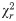
Results from reweighting the simulation with underestimated protein-water interaction strength (λ = 1.04).(A) Fit to SAXS data with adjusted force field before (black) and after reweighting at θ = 500 (green). (B) χr2 vs. ϕeff for a selection of θ. (C) Rg calculated from structures during the simulation, including the mean value (black), experimental Rg from SAXS (red), and mean Rg from the reweighted ensemble (green). Corresponding histograms in the right panel. (D) Calculated D13 before and after reweighting.